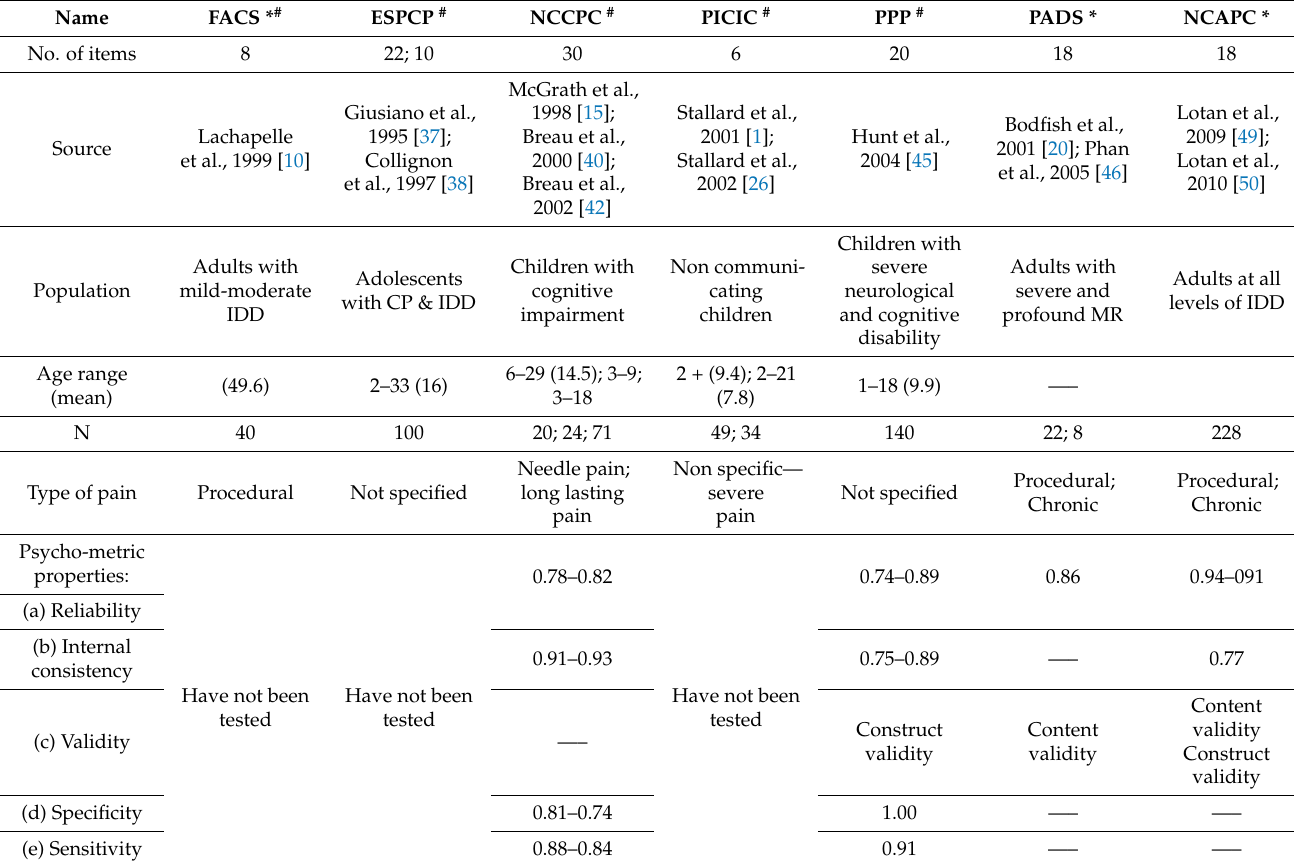
Table A1. A comparative summary of existing pain scales for individuals with